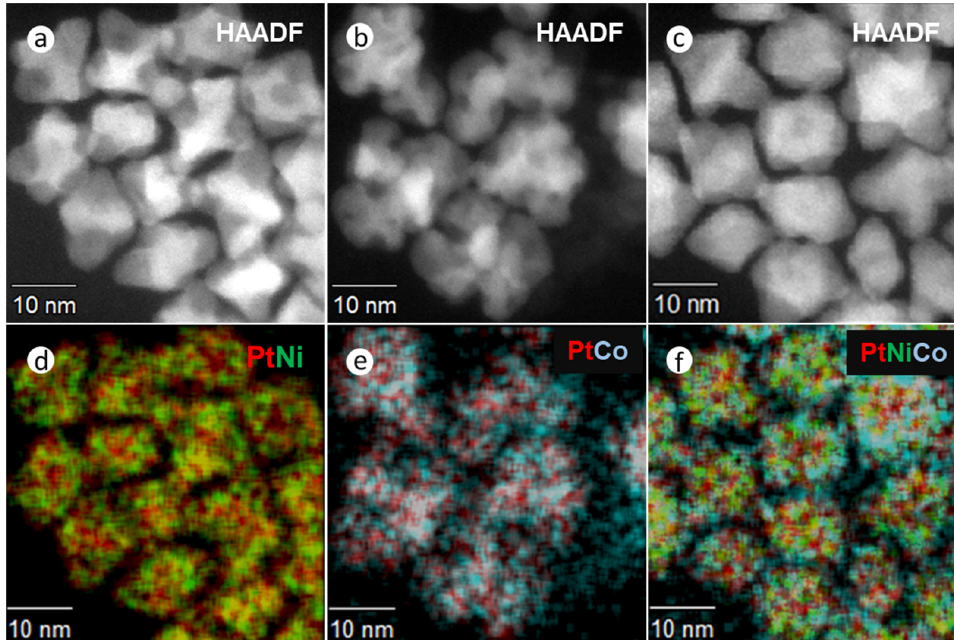
Figure 2. HAADF and STEM-EDS elemental distribution examination of PtNi, PtCo and Pt(NiCo) alloy NPs synthesized by Synthesis Method (a) (i). HAADF images of ( a ) PtNi, ( b ) PtCo and ( c ) Pt(NiCo) alloy NPs. ( d – f ) Composite EDX spectroscopic mappings of Ni (Kα, green), Co (Kα, cyan), and Pt (Lα, red) reveal inhomogeneous distributions of two solid solutions (Pt-rich and M-rich phases) within the alloy NPs.